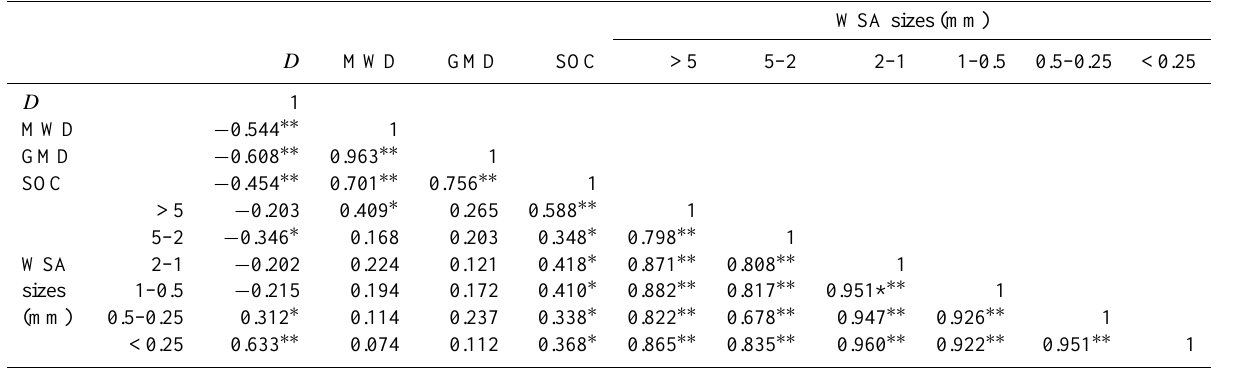
Table 5. Correlation between parameters of water-stable